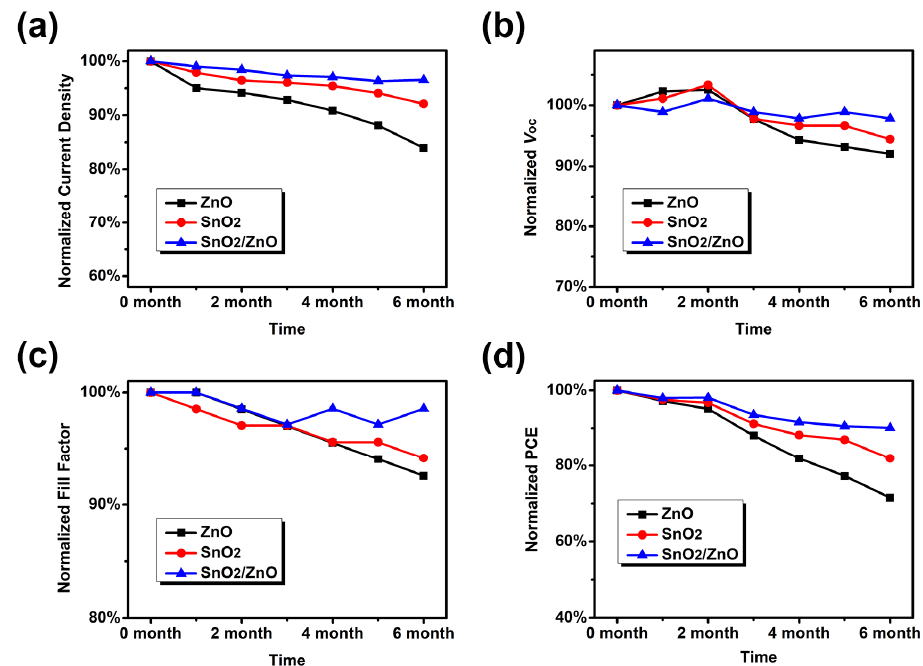
Figure 6. The normalized photovoltaic performance curves of devices in air: (a) for J SC ; (b) for V OC ; ( c ) for FF; ( d ) for (c) for FF; (d) for PCE.